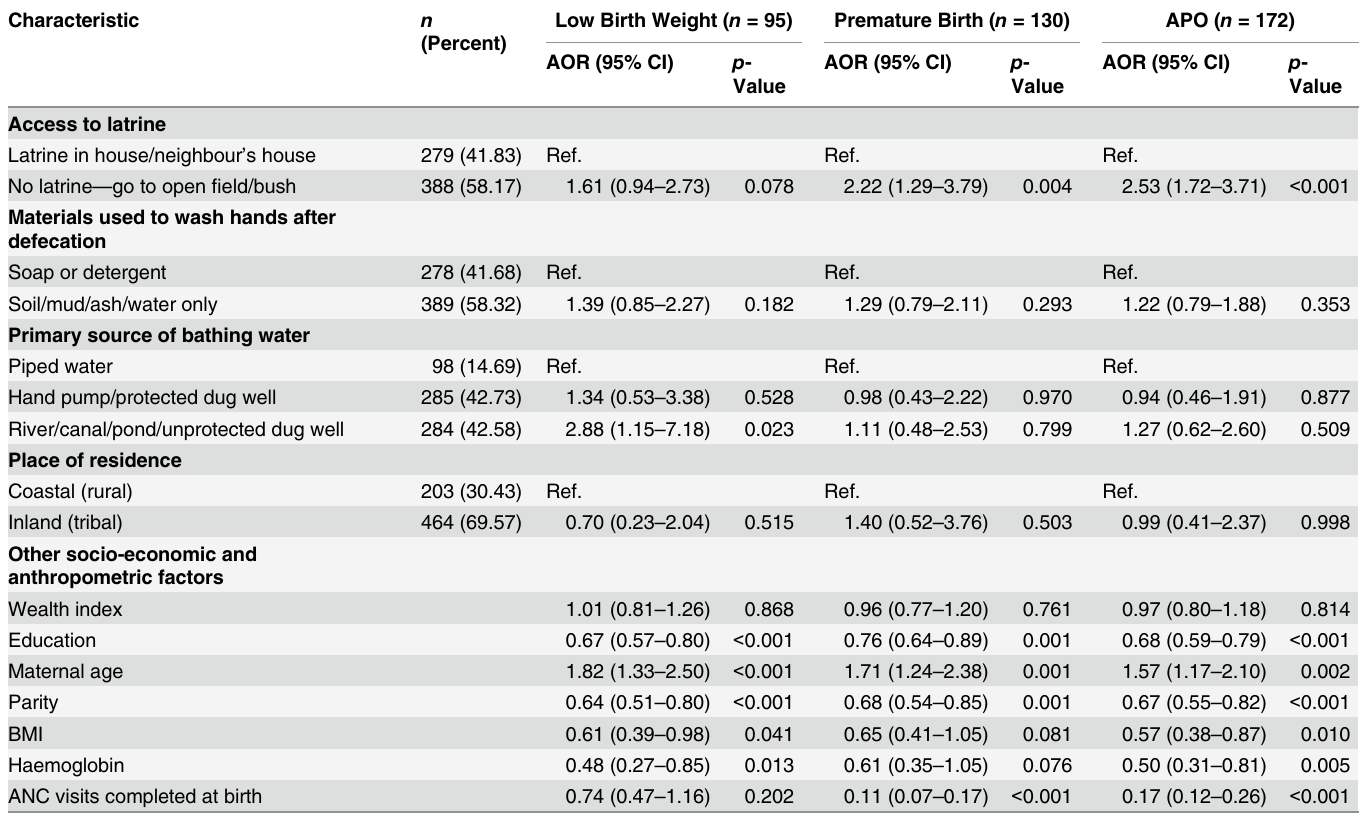
Table 3. Multivariable adjusted models for the association between sanitation characteristics and adverse pregnancy outcomes ( n =